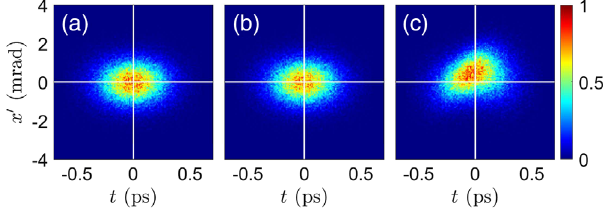
FIG. 5. Beam-slice distribution with various conditions. (a) Reference case in which CSR is not included. (b) CSR is included but fully suppressed by optimizing the Twiss parameters to achieve zero emittance growth. (c) CSR is included and not suppressed, resulting in an emittance growth of 10%. The beam head is placed at negative t , and the tail is placed at positive